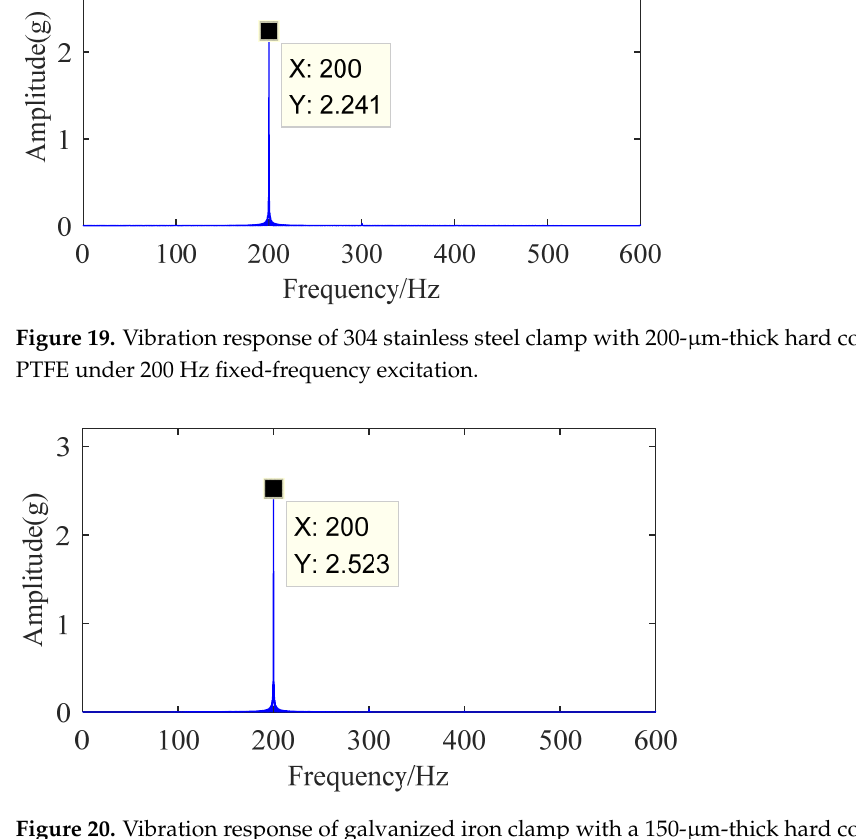
Figure 20. Vibration response of galvanized iron clamp with a 150- μ m-thick hard coating of Z r O 2 - PTFE under 200 Hz fixed-frequency excitation.